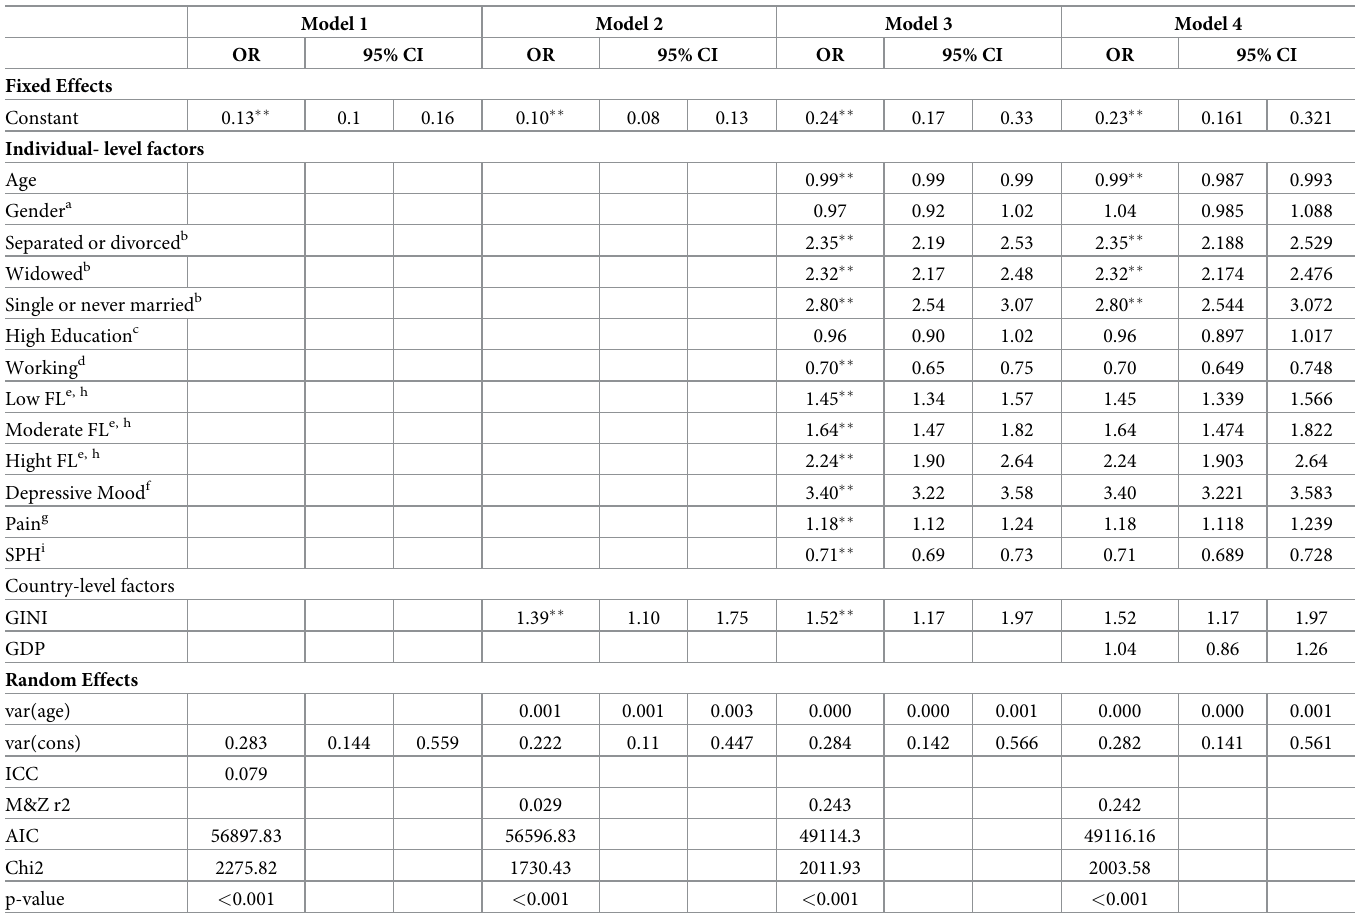
Table 3. Hierarchical logistic model for the prevalence of loneliness (n =